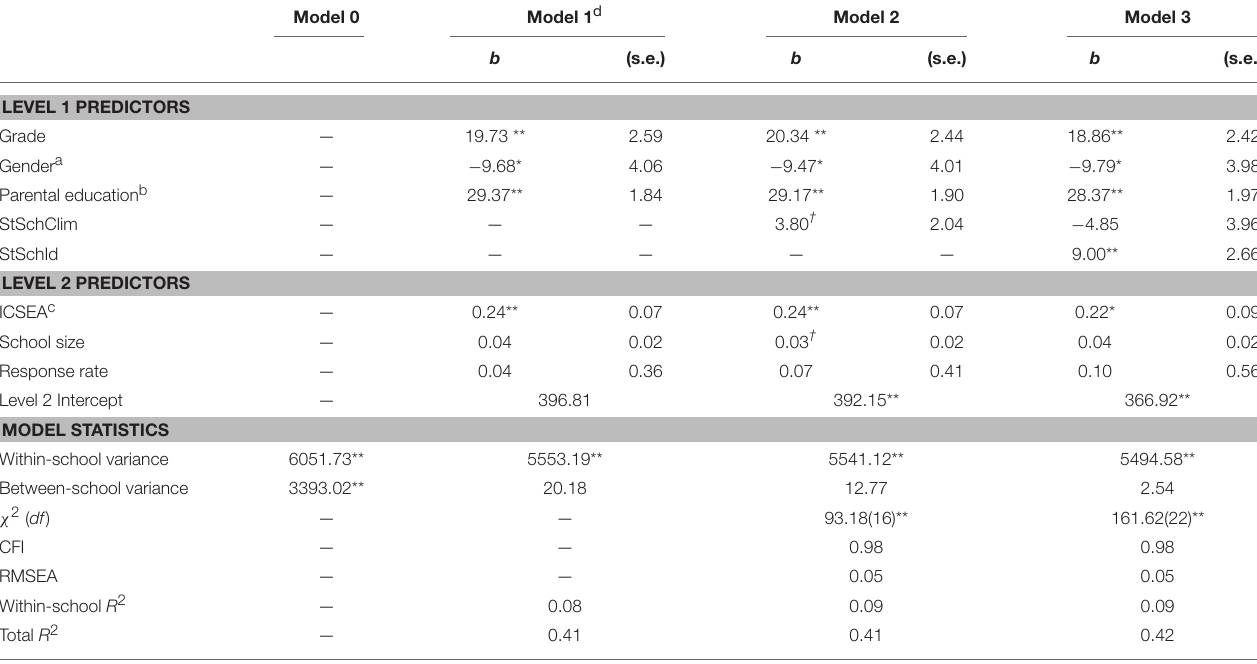
TABLE 3 | Multilevel SEM results for models 0–3 explaining NAPLAN